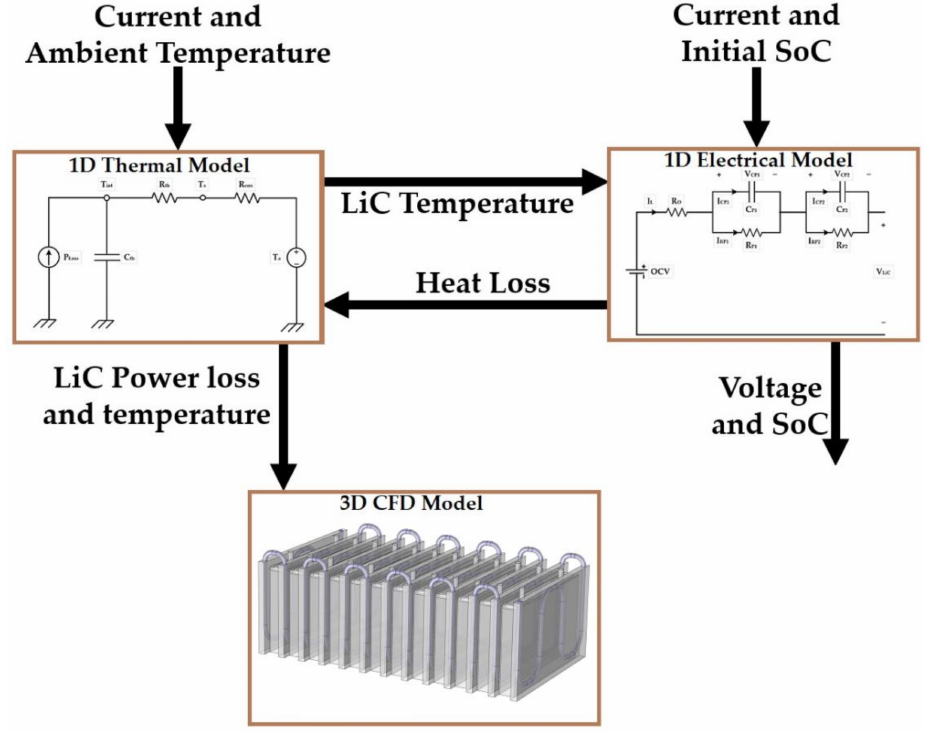
Figure 1. The 1D electro-thermal model coupled to the 3D CFD